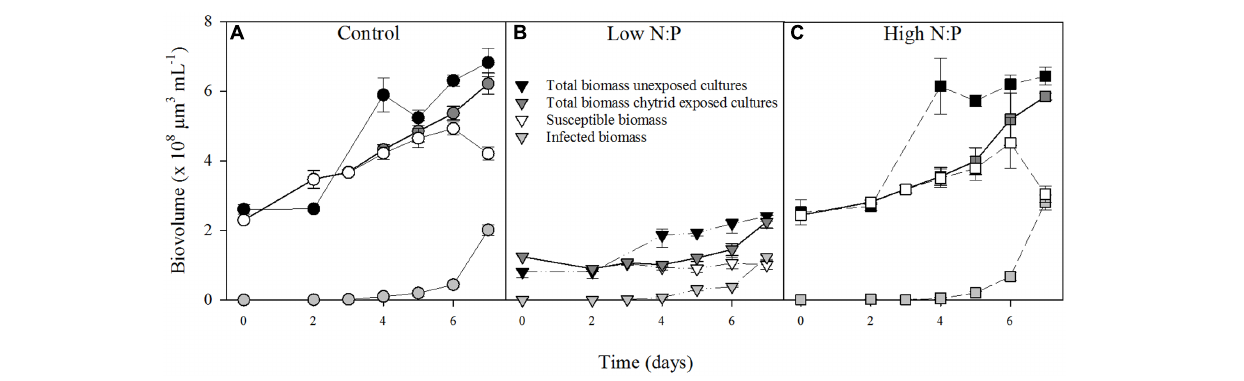
Superscript letters denote significant differences between nutrient treatments based on One-way ANOVA and post hoc comparison of the means ( α < 0.05).